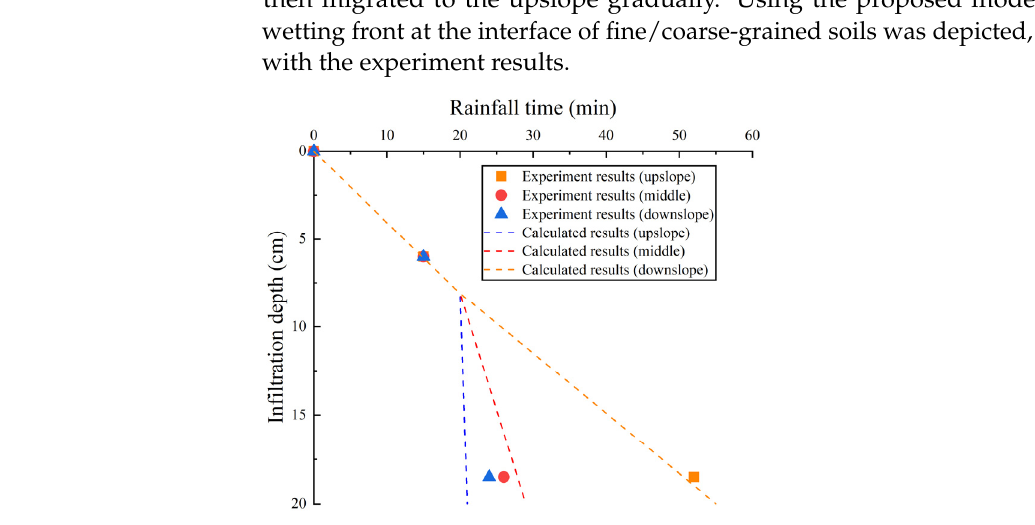
Figure 9. The relationship between infiltration depth and rainfall time (the points are the experimental results [55]; the dotted lines are the calculated results using the proposed method).